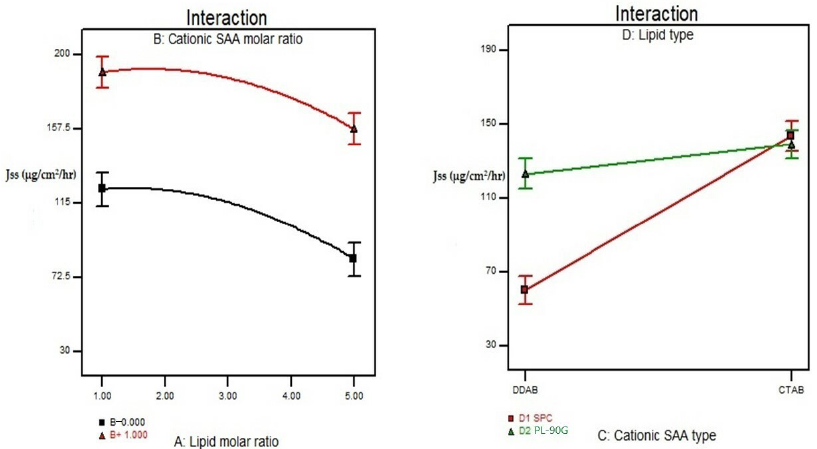
Figure 4. The effect of lipid molar ratio (X 1 ), cationic surfactant molar ratio (X 2 ), cationic surfactant type (X 3 ), and lipid type (X 4 ) on Jss. Abbreviation: Jss, steady-state